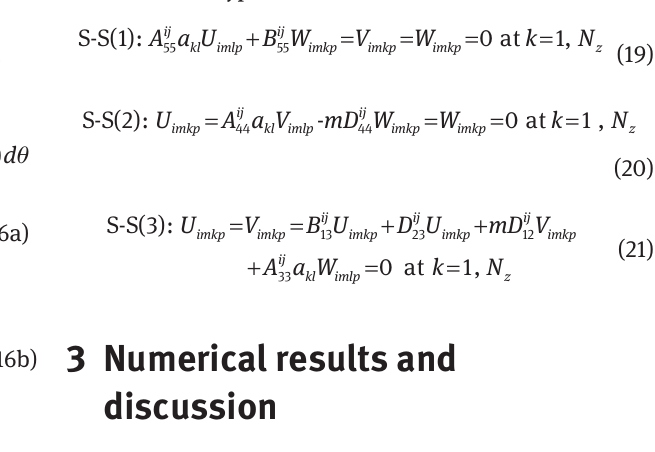
Simply supported boundary conditions: the bound- ary conditions for the mid radial grids are the same as the clamped boundary conditions and for the other radial grids located on boundaries are defined as the following three different